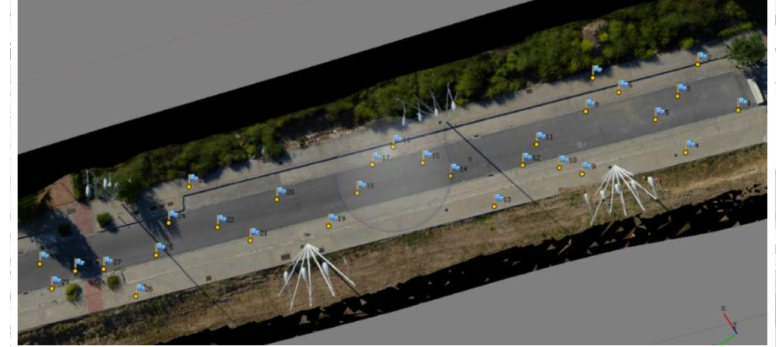
Figure 3. Flight test zone.